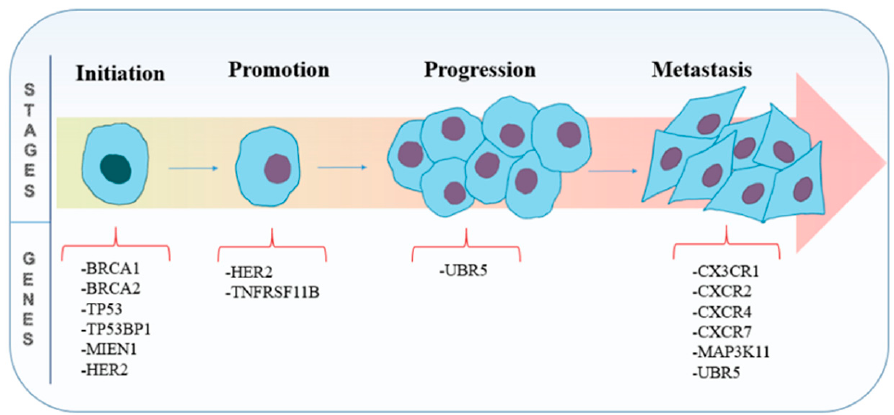
Figure 4. The different stages involved in carcinogenesis of breast cancer with respect to some of the contributing genes.